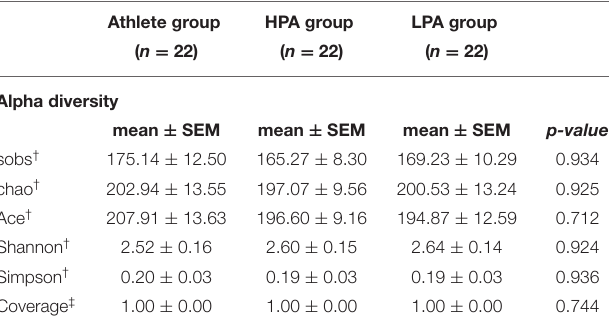
TABLE 2 | Difference in alpha diversity of gut microbiota composition among athletes and young adults.